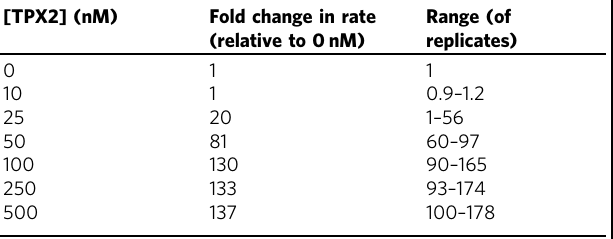
Table 1 MT nucleation rates of full-length